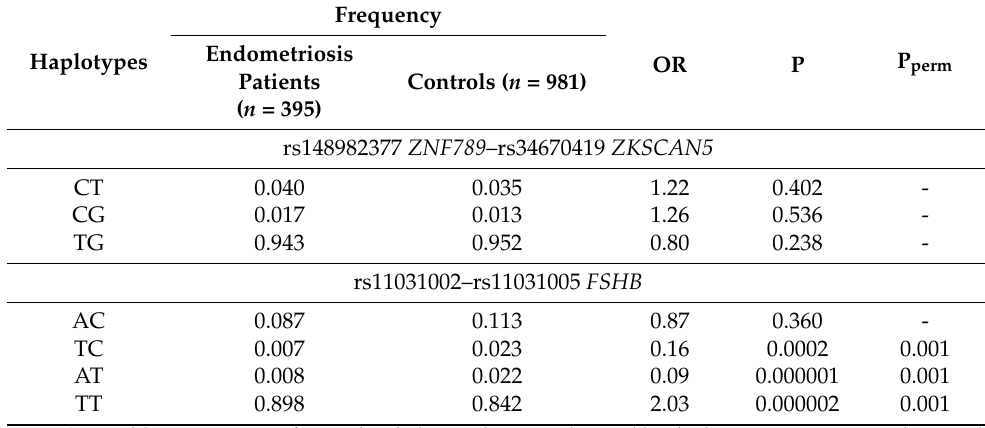
Table 2. Associations of the gene-candidate haplotypes of sex hormone level with endometriosis.